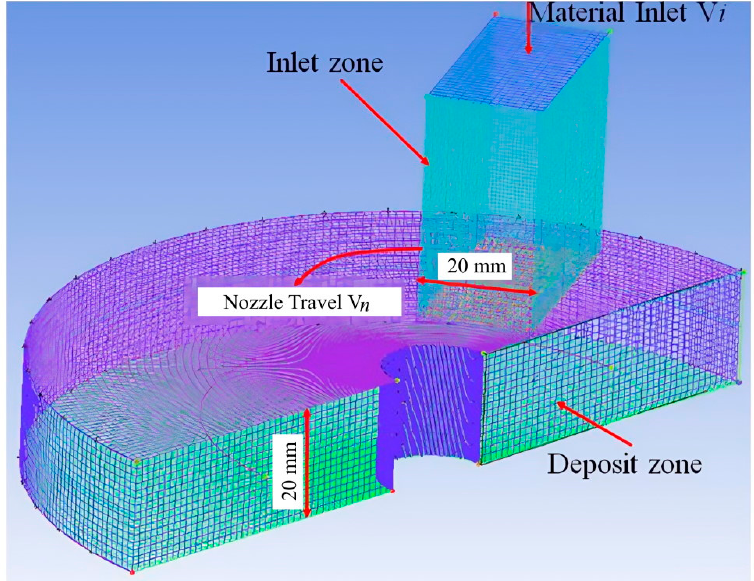
Figure 1. Exemplary simulation domain of cementitious material extrusion and deposition of 3DCMP with radial toolpath. Image extracted from Ref. [8].